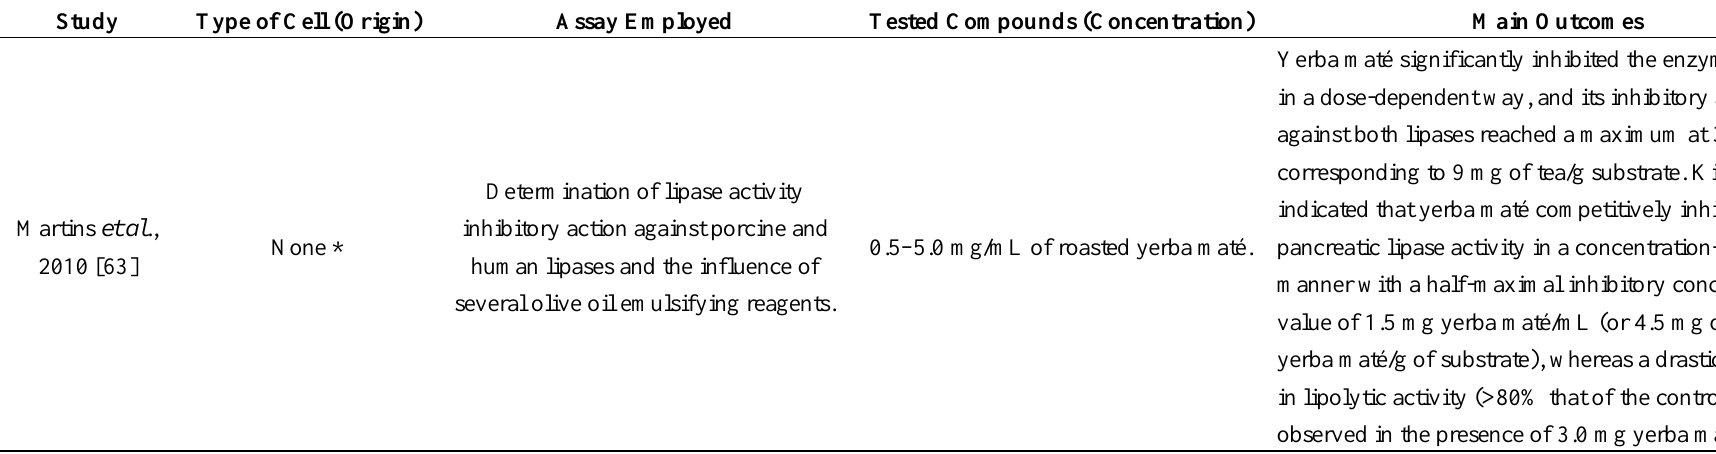
Table 2. In vitro effects of yerba maté on